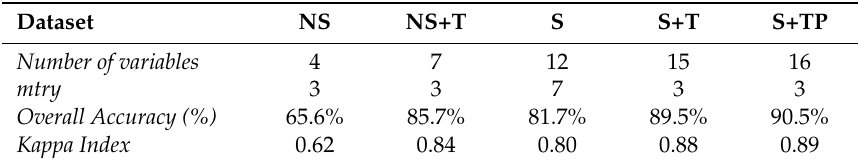
Table 5. Increases in classification accuracy achieved with multi-seasonal spectral variables, topographical information, and precipitation data.